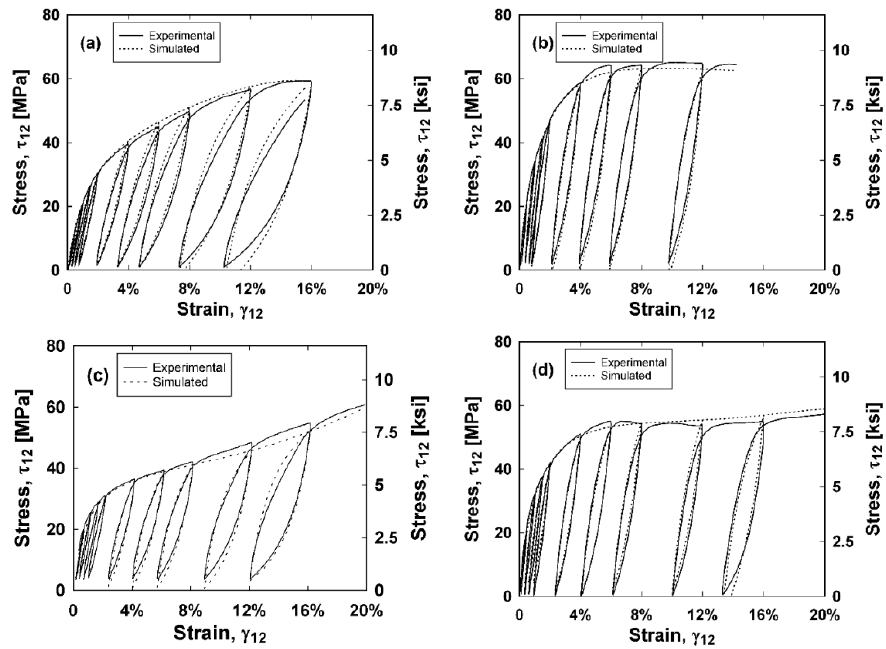
Figure 9. Experimental and simulated ( a ) E-glass; ( b ) E-glass hybrid; ( c ) S-glass; and ( d ) S-glass hybrid composite shear stress – shear strain curves.